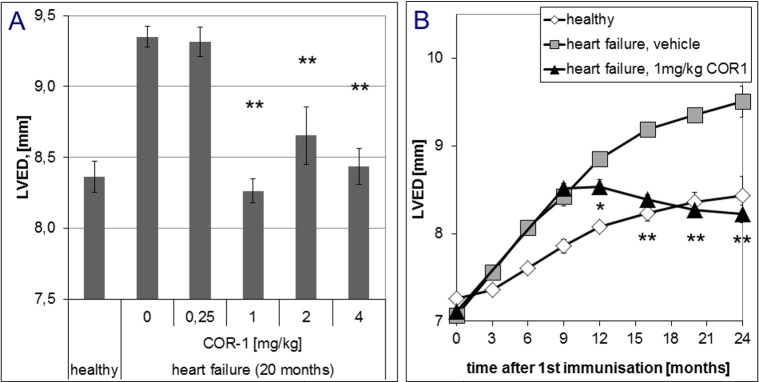
Effect of COR-1 on the left ventricular end-diastolic diameters (LVED) of rats with HF induced by immunisation with GST-ß1EC2 fusion proteins.A: Effects of COR-1 on LVED (with SEM)of immunized rats after ten treatments (20 months after the first immunization), including the ß1EC2HF vehicle control group (COR-1 0 mg/kg; n = 8), the ß1EC2HF groups treated with 0.25 mg/kg (n = 4), 1 mg/kg (n = 20), 2 mg/kg (n = 5) or 4 mg/kg BW COR-1 (n = 9) vs. healthy control animals (n = 9).The resulting ANOVA analyses showed overall significance, and post-hoc specific inter-group p values were 0.000 for HF + vehicle vs. healthy, 0.002 for HF + 0.25 mg/kg COR-1 vs. healthy, and 0.000 for HF + 1 mg/kg COR-1 vs. HF + vehicle, 0.032 for HF + 2 mg/kg COR-1 vs. HF + vehicle, 0.000 for HF + 4 mg/kg COR-1 vs. HF + vehicle. All other post-hoc analyses yielded non significant results. B: Time course of LVED obtained by echocardiography from healthy rats (white diamonds) and ß1EC2HF rats treated with vehicle (grey squares) or 1 mg/kg BW COR-1 (black triangles)every four weeks starting 10.5 months after the first immunization. At least four animals were analyzed independently per group and time point.* indicates statistical significance (p<0.05), and ** indicate strong statistical significance (p<0.005),when compared to the vehicle group with heart failure. Analysis of variance followed by Scheffe´s post-hoc test showed no difference at baseline, but significant (p < 0.005) worsening of LVED in HF rats compared to healthy control rats after 3 and 6 months (and all time points thereafter). HF rats treated with 1, 2 or 4 mg/kg BW COR-1 differed significantly (p<0.005) from the HF vehicle group, and did not differ from healthy control rats at 12, 16, 20 and 24 months (groups with 2 mg/kg and 4 mg/kg BW not shown to improve clarity of the image).